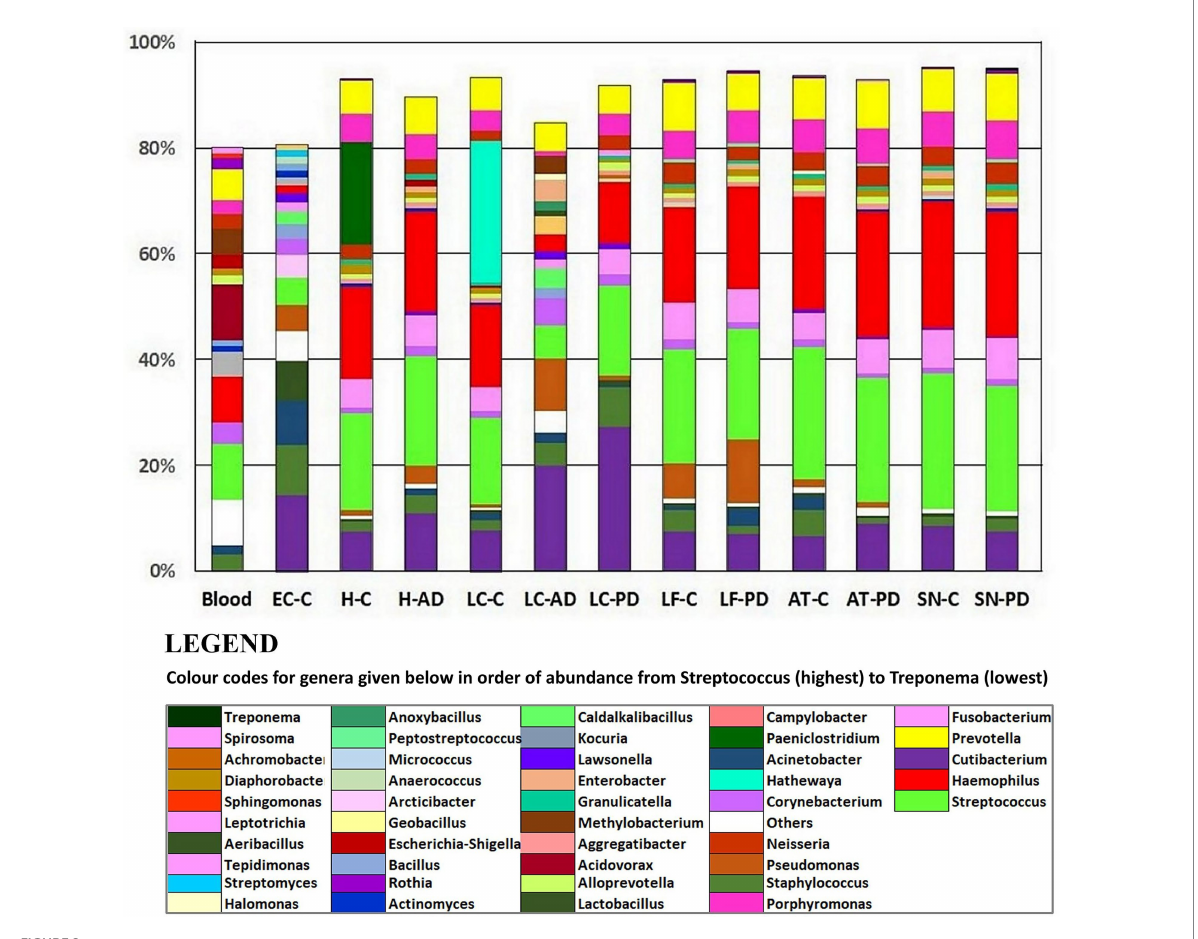
FIGURE 2 Relative abundances at the genus level using taxonomic assignment based on 97% OTU clustering (Novogene). Included are averaged relative abundance composition of 4 blood samples from a previous study (Emery et al., 2021) which are provided for comparison. AD, Alzheimer’s disease; C, control; PD, Parkinson’s disease. AT, anterior temporal pole (BA38); EC, entorhinal cortex (BA34); H, hippocampus; LC, locus coeruleus; LF, lower frontal cortex (BA11); SN, substantia